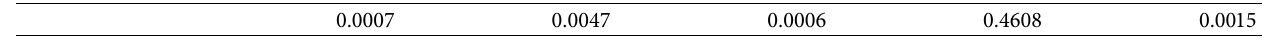
t and their parametric